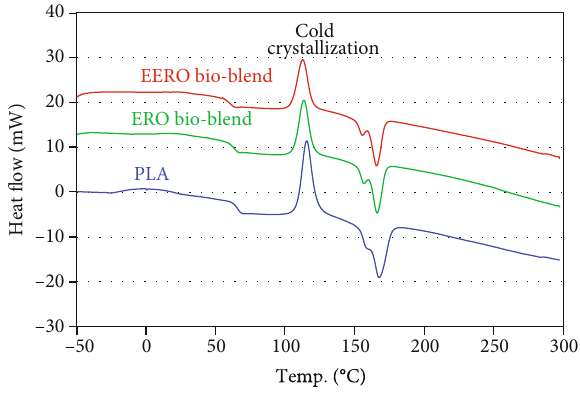
Figure 5: DSC thermograms of samples. Table 3: The characteristics of thermal properties.